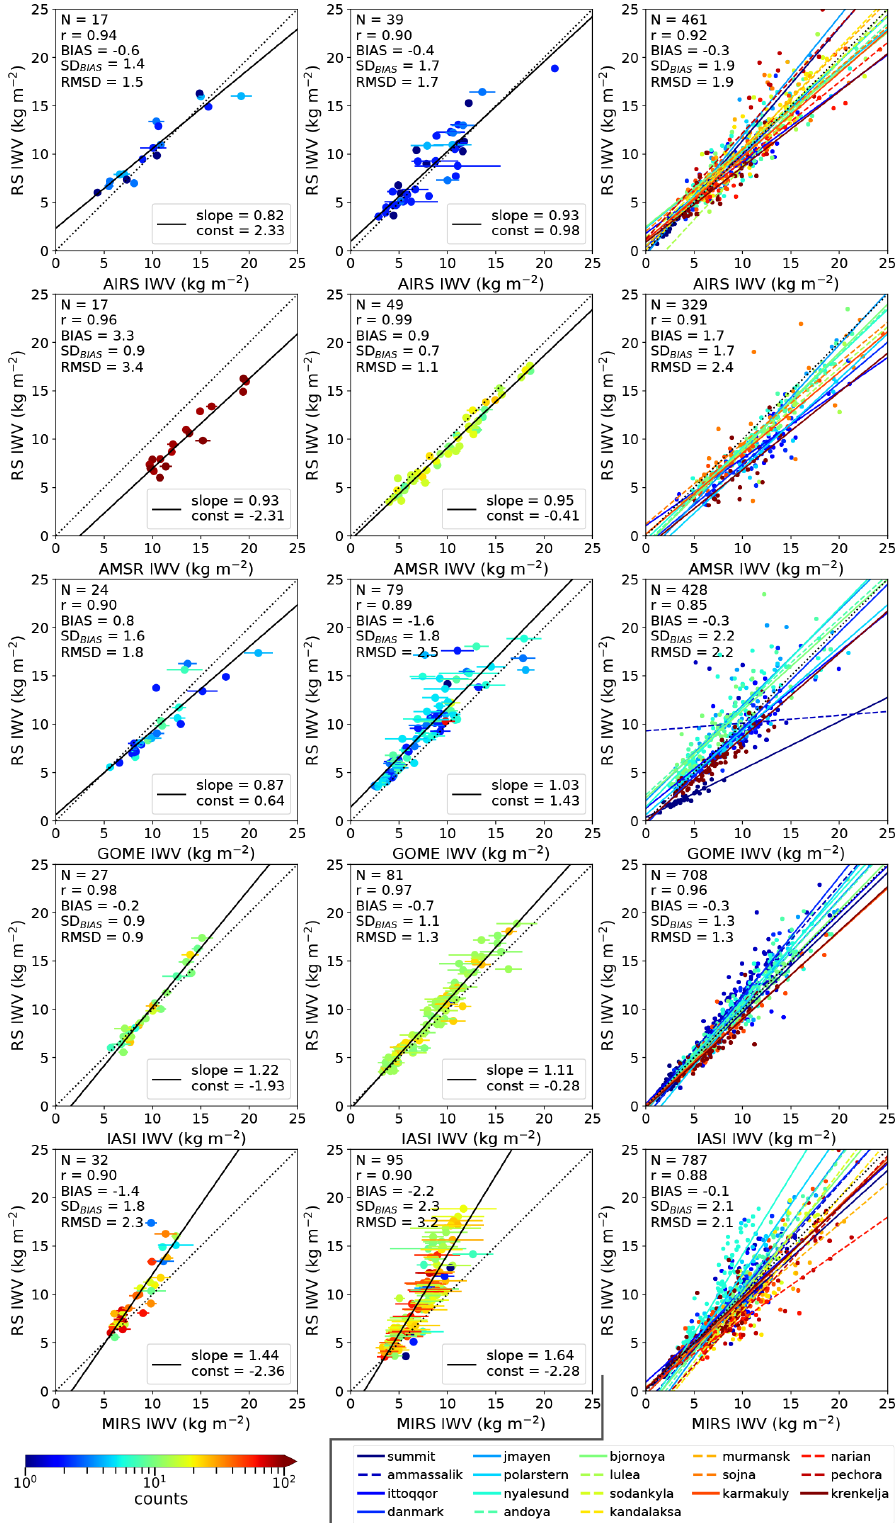
Figure 5. Scatterplots for radiosondes launched at the Polarstern (left column) and Ny-Ålesund (middle column) and for all other radiosonde stations (right column) with corresponding ( ± 30min and 50km radius) satellite measurements (from top to bottom row: AIRS L2 v6 IR- Only, AMSR, GOME-2, IASI L2 PPFv6, MIRS) above all surfaces. All satellite pixels falling into this criterion have been averaged, and their SD is indicated by the width of the line. The number of averaged pixels is indicated by color for the first two columns only. Atmos. Meas. Tech., 14, 4829–4856,